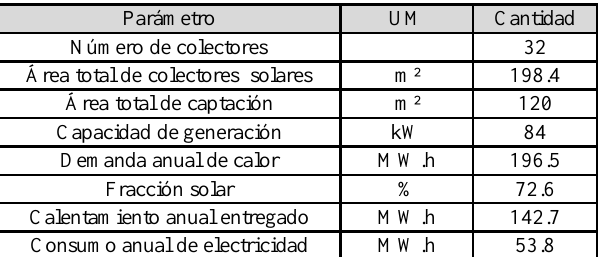
Tabla 2: Principales características del sistema solar